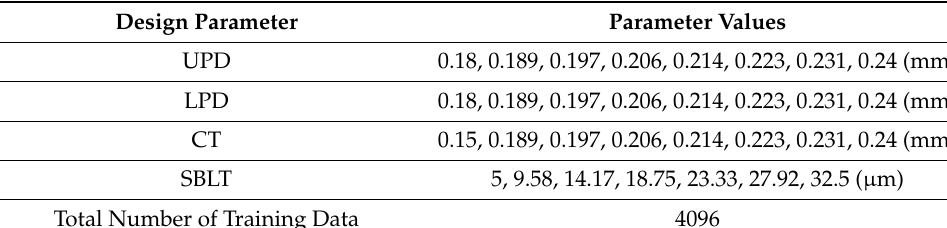
Table 10. Design parameters for 4096 training data.